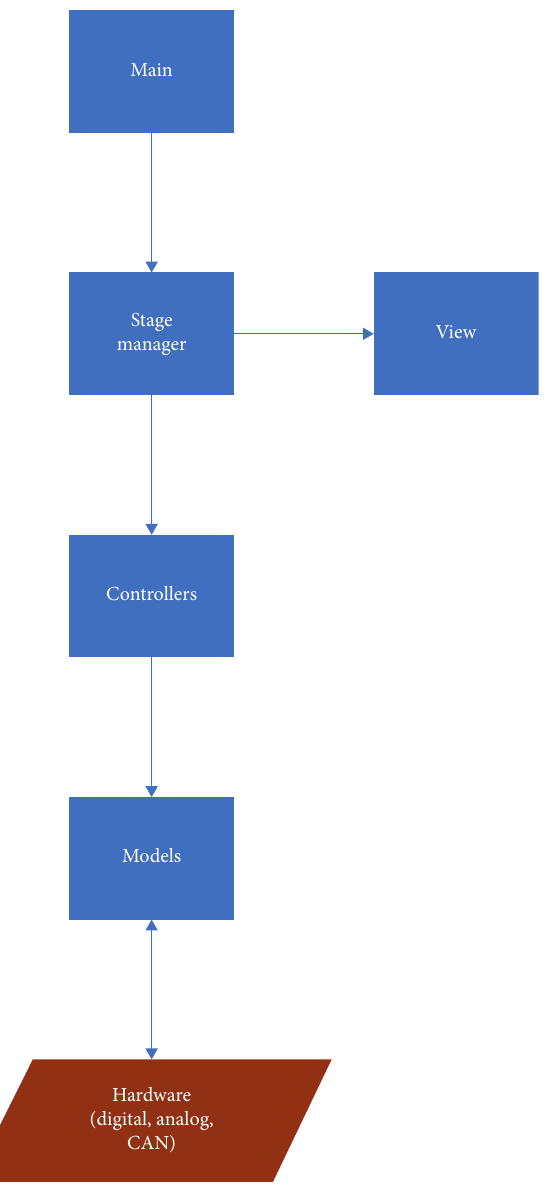
Figure 10: A simplified diagram of the